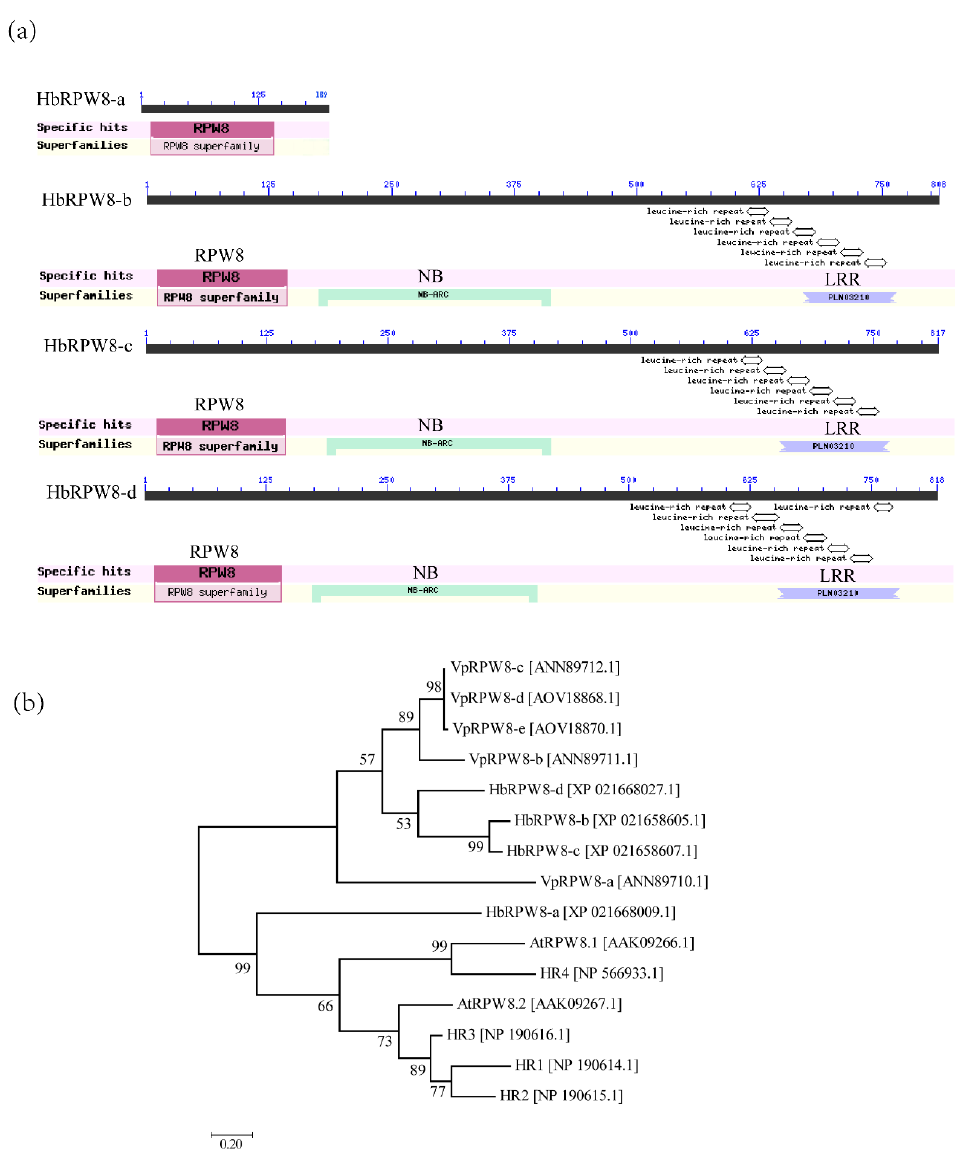
Figure 1. Protein domain and phylogenetic analysis of HbRPW8s. ( a ) Protein domain analysis of HbRPW8s. HbRPW8s contained RPW8 domain, conserved disease resistance domains NB (nucleotide binding sites) and LRR (leucine-rich repeats), except for HbRPW8-a, with only the RPW8 domain (7-128aa); ( b ) phylogenetic analysis of HbRPW8s with other RPW8s in V. pseudoreticulata and A . thaliana